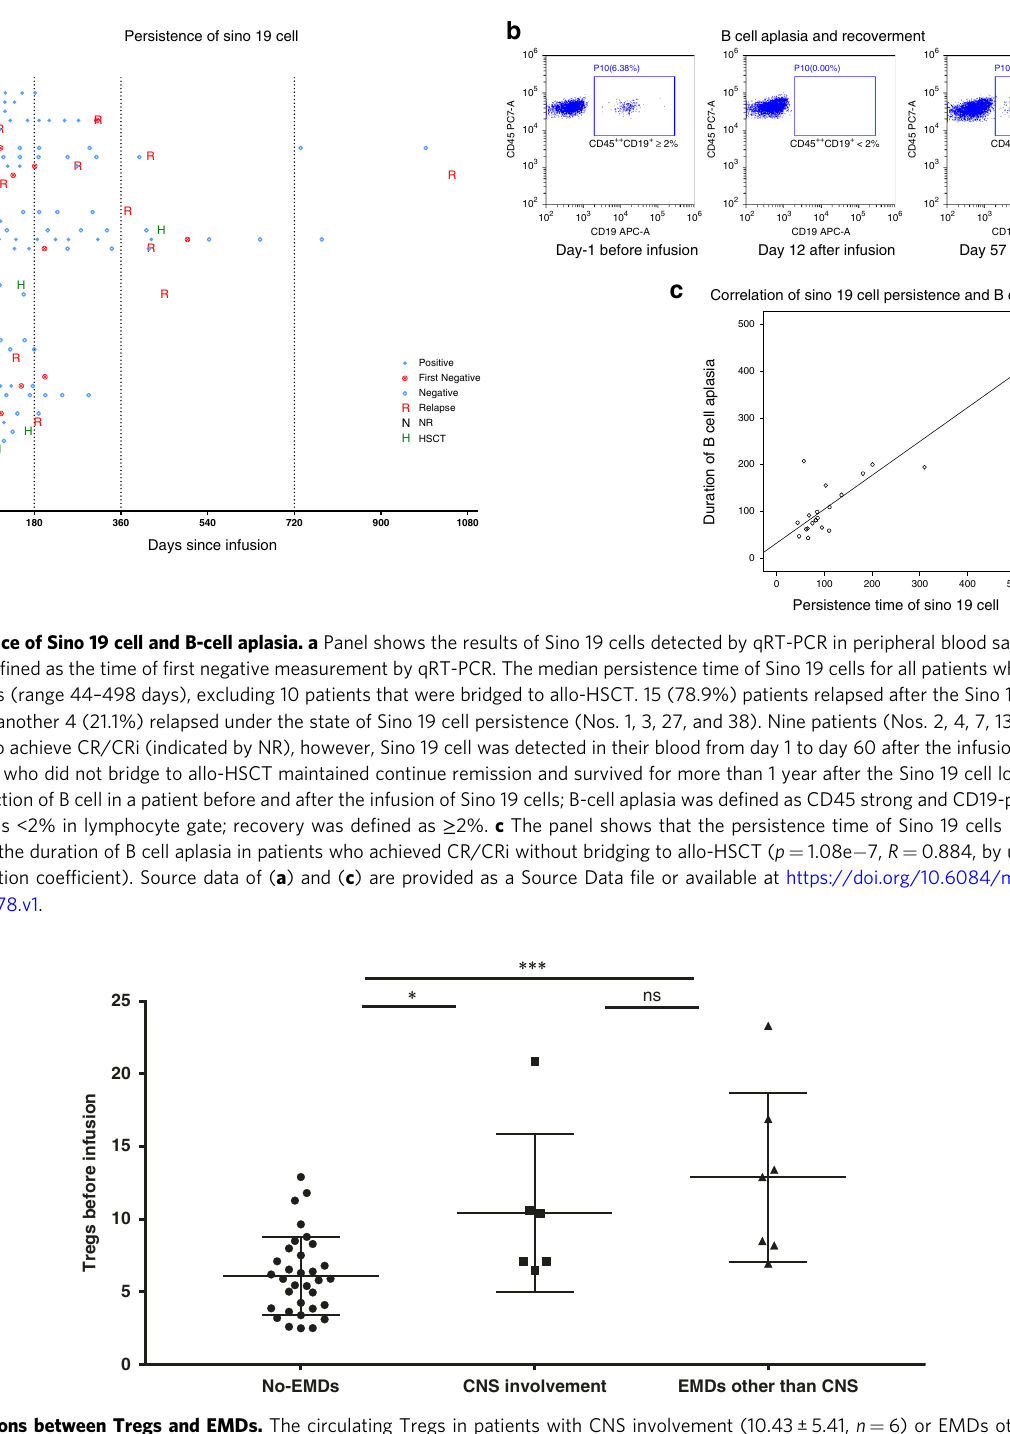
Fig. 5 Correlations between Tregs and EMDs. The circulating Tregs in patients with CNS involvement (10.43 ± 5.41, n = 6) or EMDs other than CNS (12.88 ± 5.79, n = 7) all higher than that in patients without EMDs (6.11 ± 2.70, n = 33) ( p = 0.011 and 6.42e − 5) respectively, but no signi fi cant difference observed between the two subtypes ( p = 0.237). Tregs levels were all measured by fl ow cytometry during post-conditioning chemotherapy and before Sino 19 cells infusion. Error bars represent mean ± SD; * represents p < 0.05; *** represents p < 0.001; ns represents no signi fi cance; mean between groups were compared by one-way ANOVA and multiple comparisons were compared using LSD tests (two-sided). p < 0.017 was considered statistically signi fi cant after Bonferroni correction ( α = 0.05/3 = 0.017). Source data is provided as a Source Data fi le or available at https://doi.org/10.6084/m9. fi